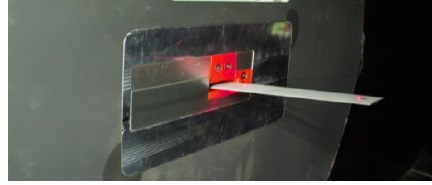
Figure 12. Wind tunnel test setup.